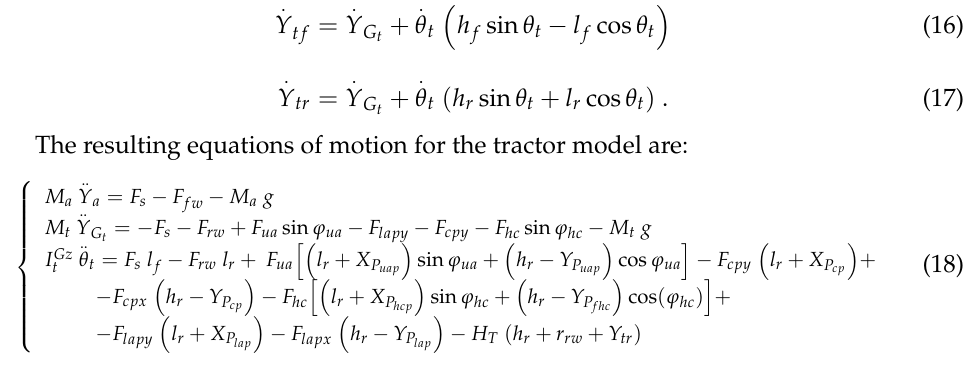
Figure 6. ( a ) The tractor model with the external loads acting on it; ( b ) displacement of the points 𝑃 𝑡𝑓 and 𝑃 𝑡𝑟 due to the sole pitch motion of the tractor.